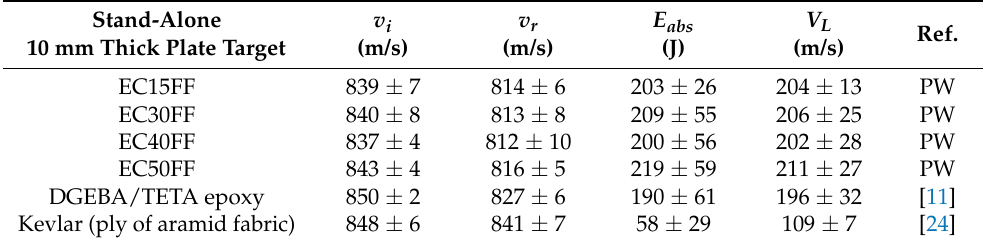
Table 2. Results of computer-recorded velocities and calculated parameters from 7.62 mm ballistic stand-alone tests for fique fabric reinforced epoxy composites, as well as previously reported results for plain epoxy and Kevlar TM . Stand-Alone